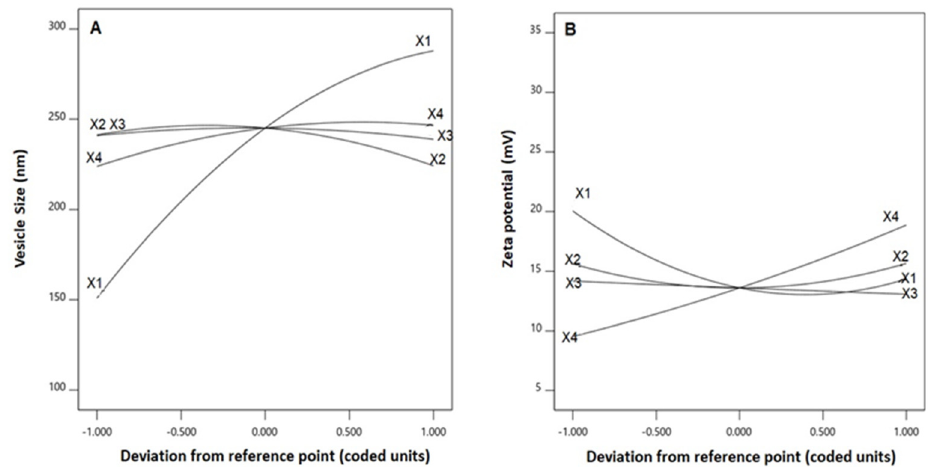
Figure 2. Perturbation graph for the effect of critical attributes; PL amount (X1), process temperature (X 2 ), reflux time (X 3 ), and SV amount (X 4 ) on ( A ) vesicle size, and ( B ) zeta potential of QRT-PHM-SV formulations. Abbreviations: QRT, quercetin; PHM, phytosomes; SV, scorpion venom peptide.